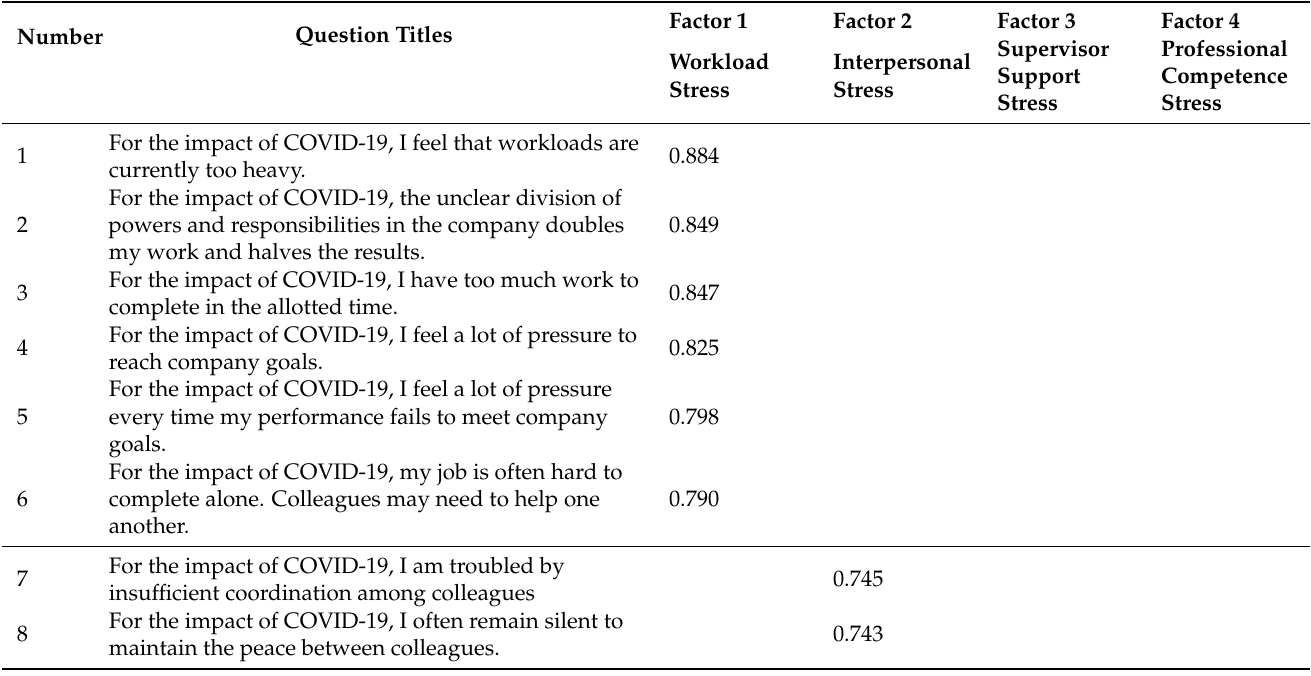
Table 2. Summary table of factor analysis in job content